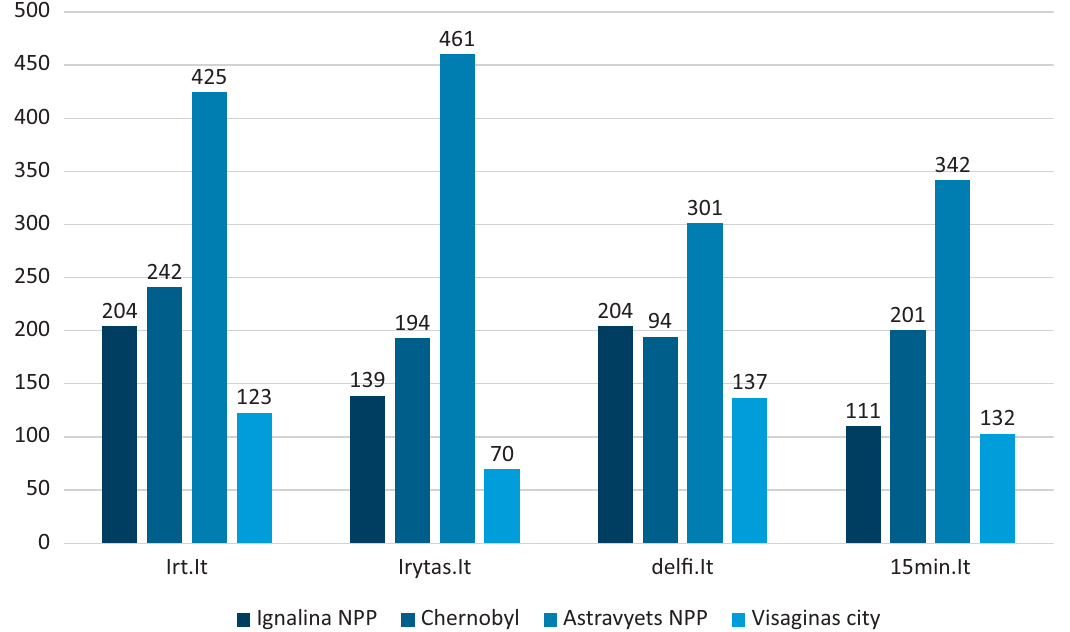
Figure 1. Number of articles examined during the period 2018–2020, all keywords. Media and Communication, 2021, Volume 9, Issue 2, Pages